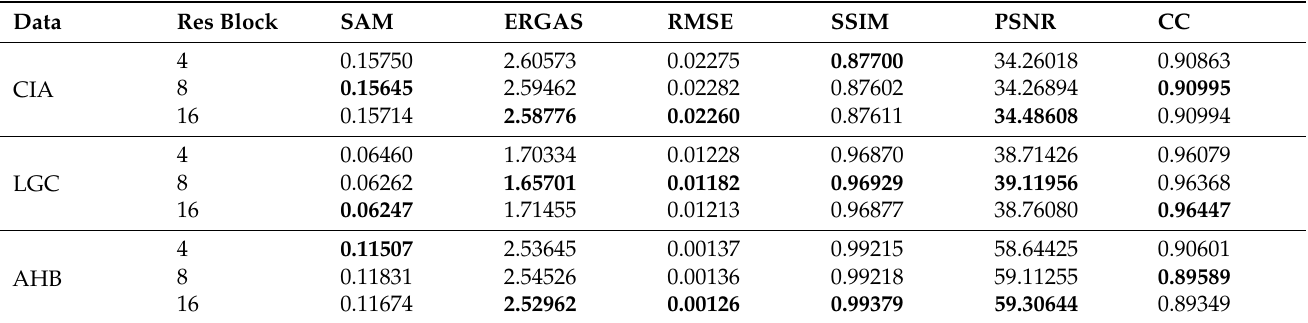
Table 5. Comparative metrics for the impact of super-resolution networks on the model at various depths on the three